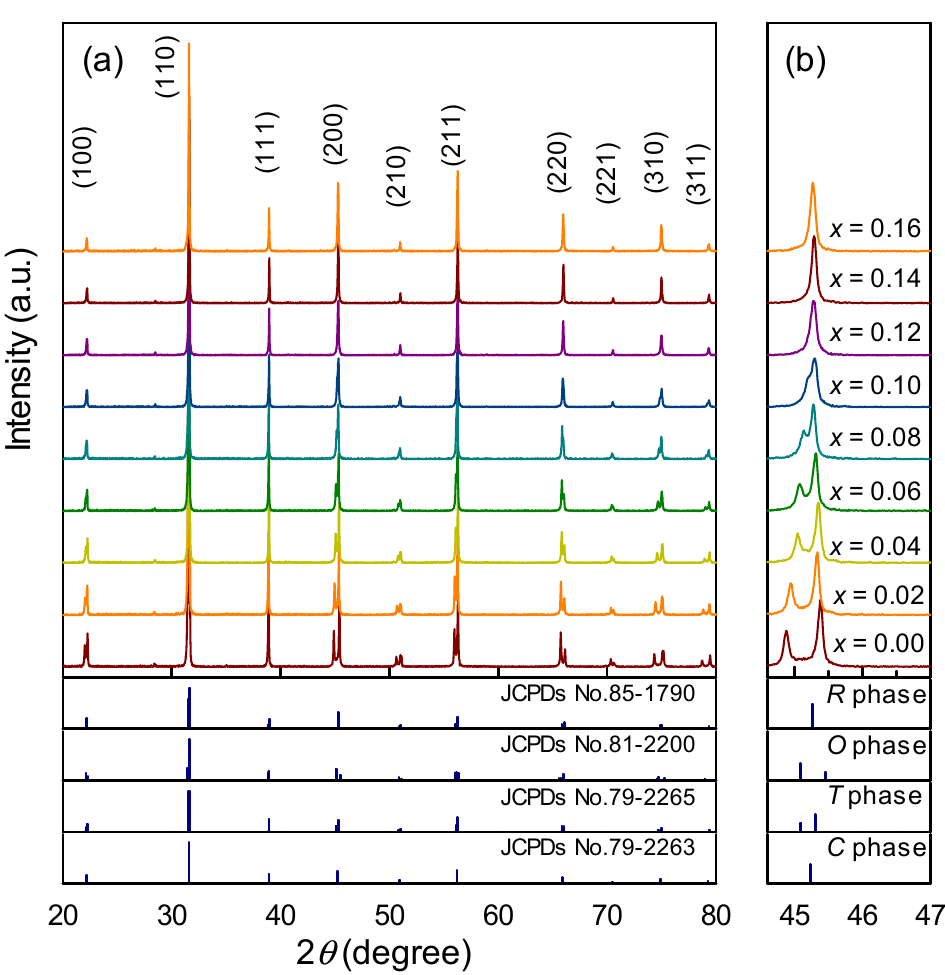
Figure 2. ( a ) Powder X-ray diffraction patterns of BT- x CS in the 2 θ range of 20–80°, and ( b ) the enlarged patterns from 44.6° to